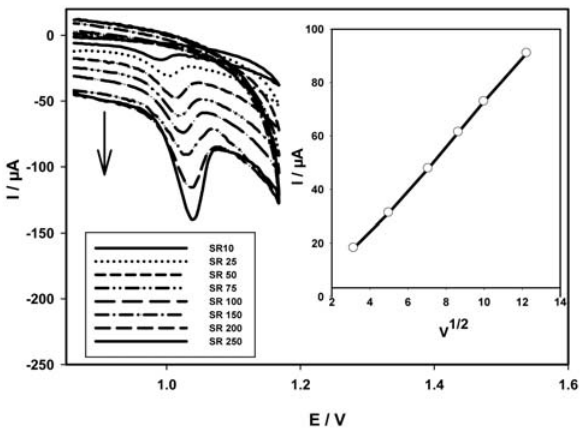
Figure 7: Cyclic voltammograms of 1.0 × 10 –3 mol/L MET at PY- CPE in BR buffer of pH 2.0 at: 10, 25, 50, 75, 100, 150, 200 and 250 mV/s. The inset: plot of the anodic peak current values versus square root of scan rate ( ν 1/2 ).